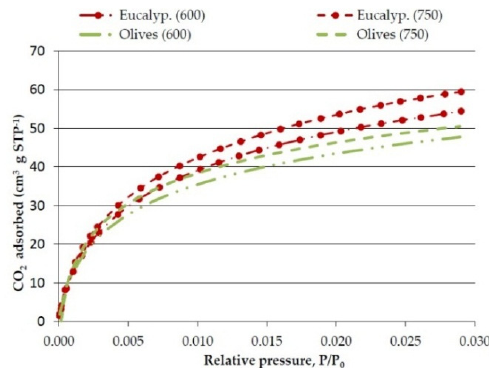
Figure 1. Effect of temperature on CO 2 adsorption isotherms of the bioreducers obtained at 20 °C ∙ min − 1 from olives and eucalyptus samples.